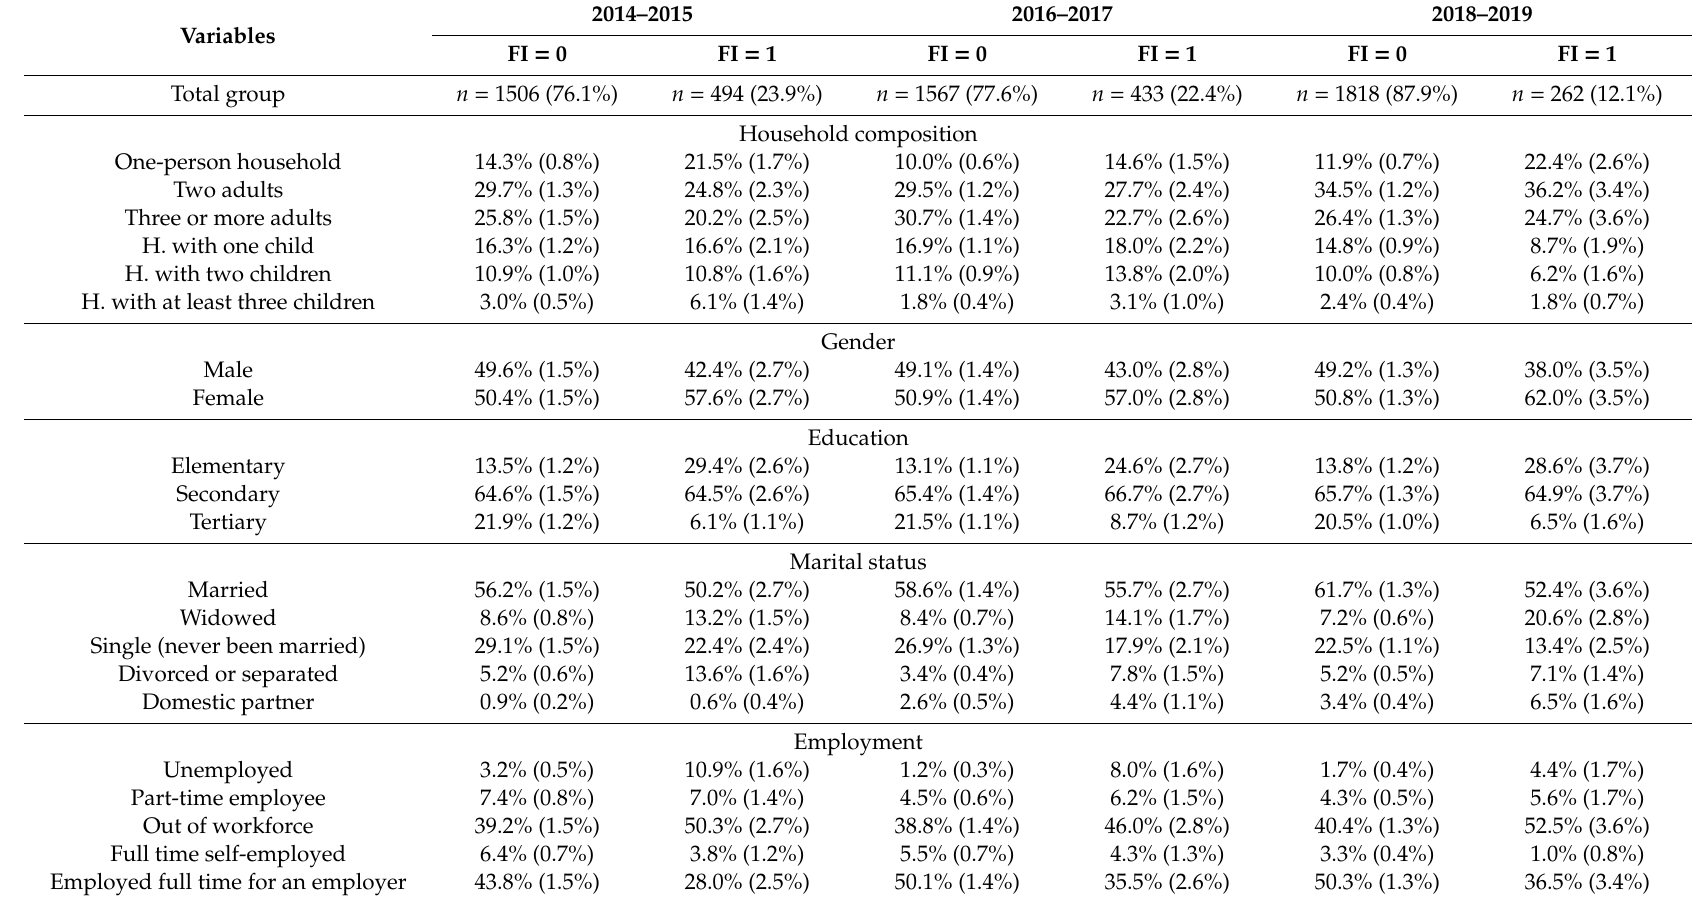
Table 2. The prevalence of food insecurity according to respondent’s characteristics (food secure FI = 0, food insecure FI = 1). Standard errors for the proportions are presented in